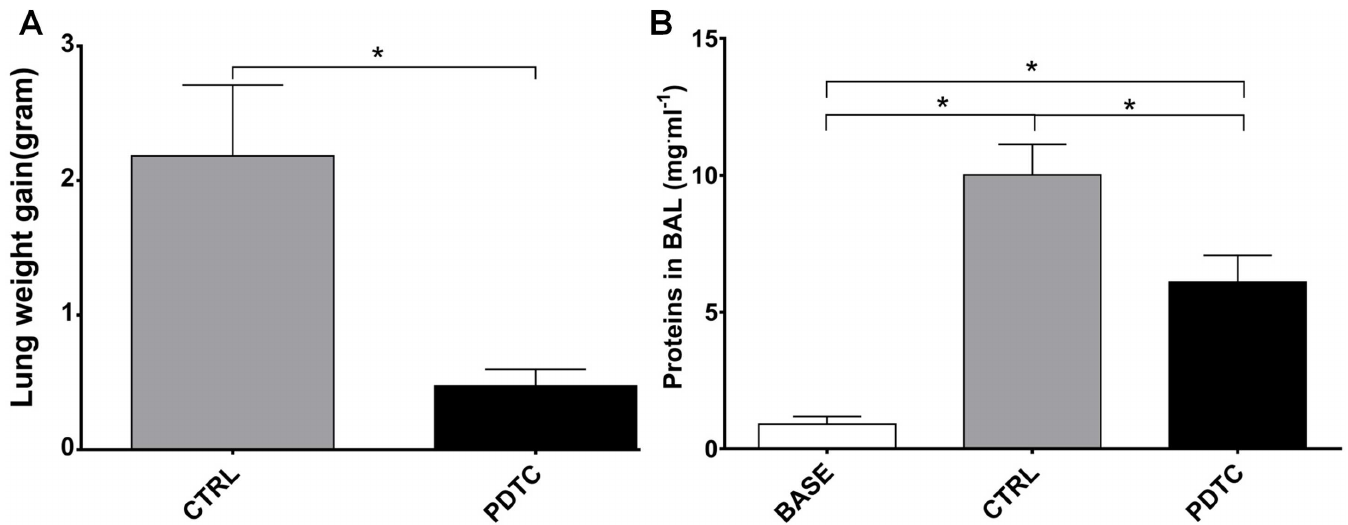
Fig 4. Indices of lung edema. A. Weight gain of the heart-lungblocks expressedin grams, represents the difference betweenweight of the heart-lung blocks measuredbefore and at the end of EVLP. B. The concentration of proteinsin the BAL fluid (in mg . ml -1 BAL fluid) was measuredas an index of high permeabilityedema. BASE: BAL fluid and was obtained from normal rats sacrificedwithout any intervention (Normal, baselinevalues, N = 3); CTRL: Ischemia followedby EVLP with Steen ® solutionalone (N = 6); PDTC: Ischemia followedby EVLP with PDTC treatment (N = 6). Means ± s.e.m. * p < 0.05 (Heart-lungblock weight gain: unpaired t test; Proteins in BAL fluid: ANOVA followedby Tukey’s test).